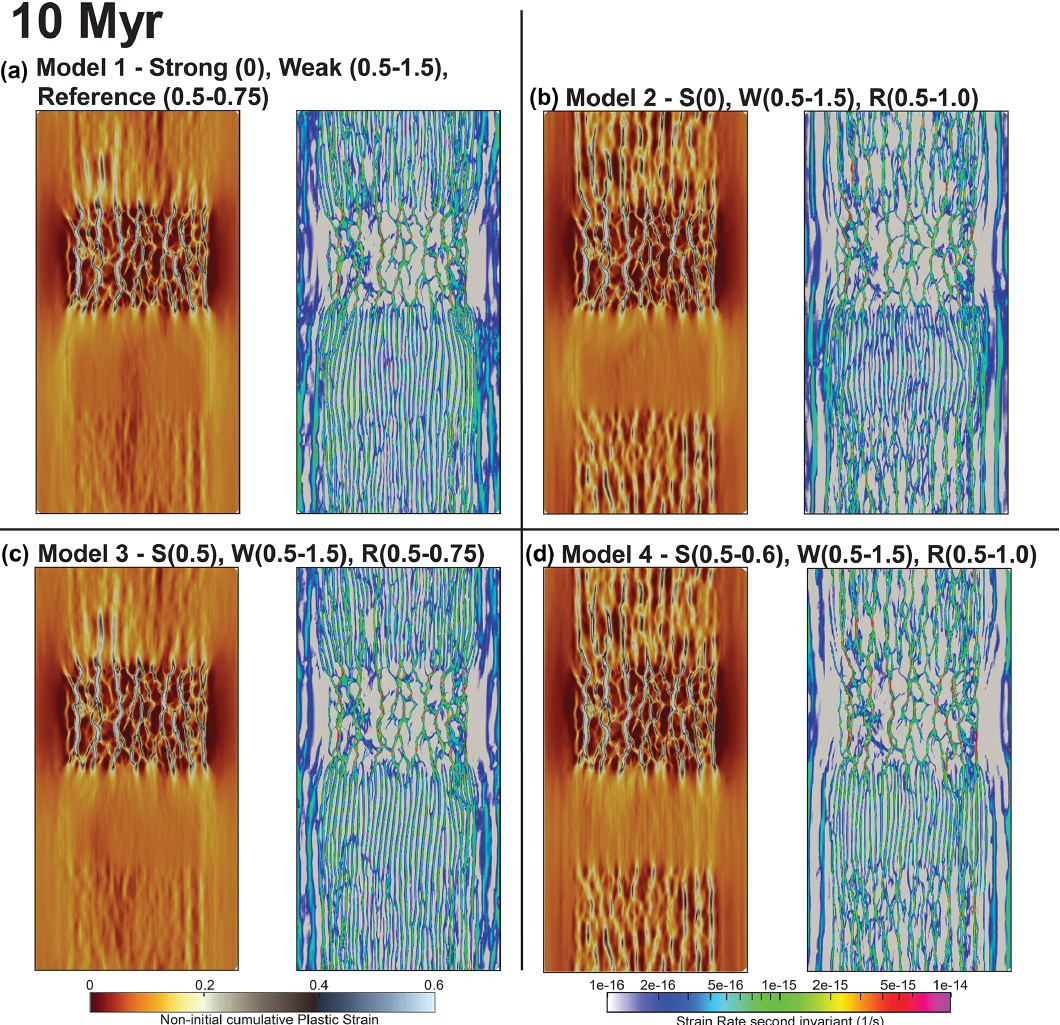
Figure 3. Map view images of each model (a–d) showing the non-initial plastic strain (a, c) and strain-rate-invariant (b, d) attributes at